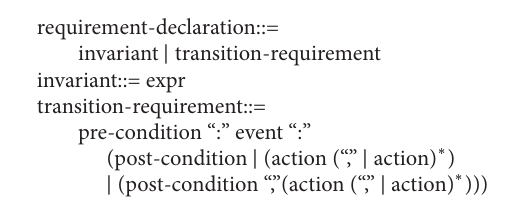
Algorithm 1: The BNF description for a transition requirement.